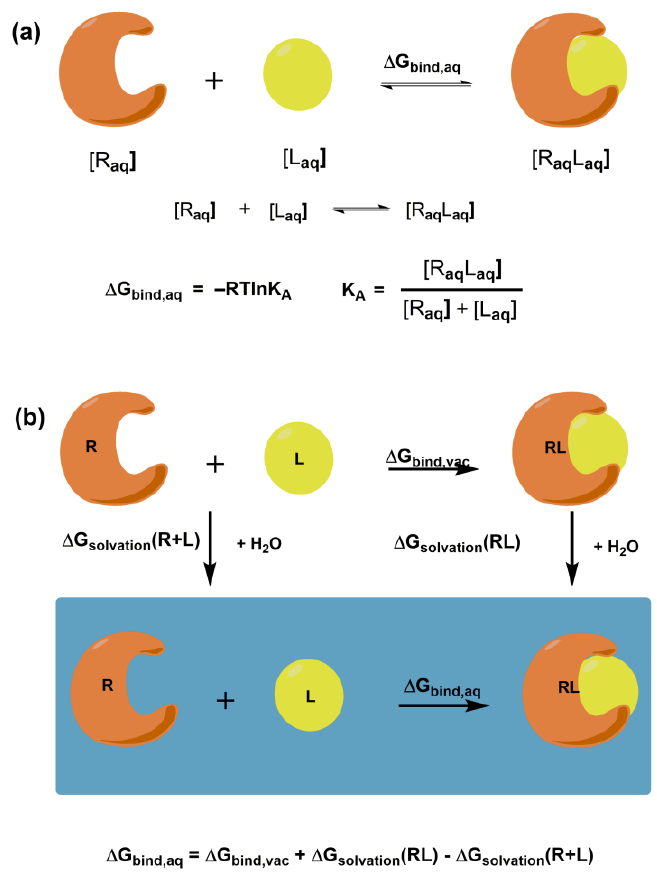
Figure 1. Schematic representation of ( a ) the free energy of binding ∆ G bind,aq for the receptor-ligand complex and its relation to binding affinity; ( b ) the thermodynamic cycle for calculating the free binding energy between the receptor and ligand.